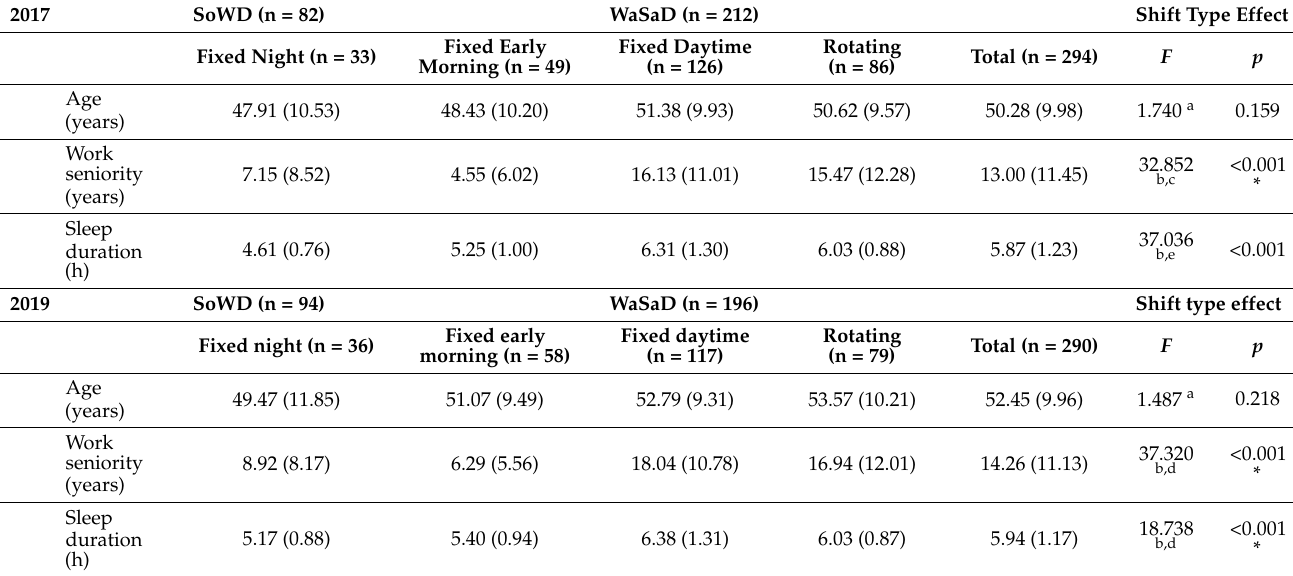
Table 1. Mean (SD) of age, work seniority and sleep duration in 2017 and 2019 by shift type, and shift types comparisons.